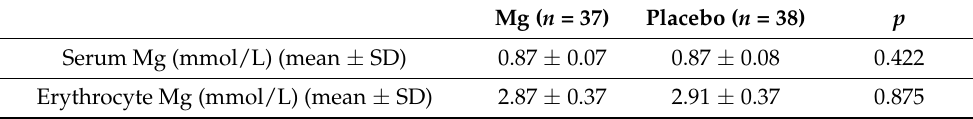
Table 4. Drug initiation after the beginning of the study ( n = 75).